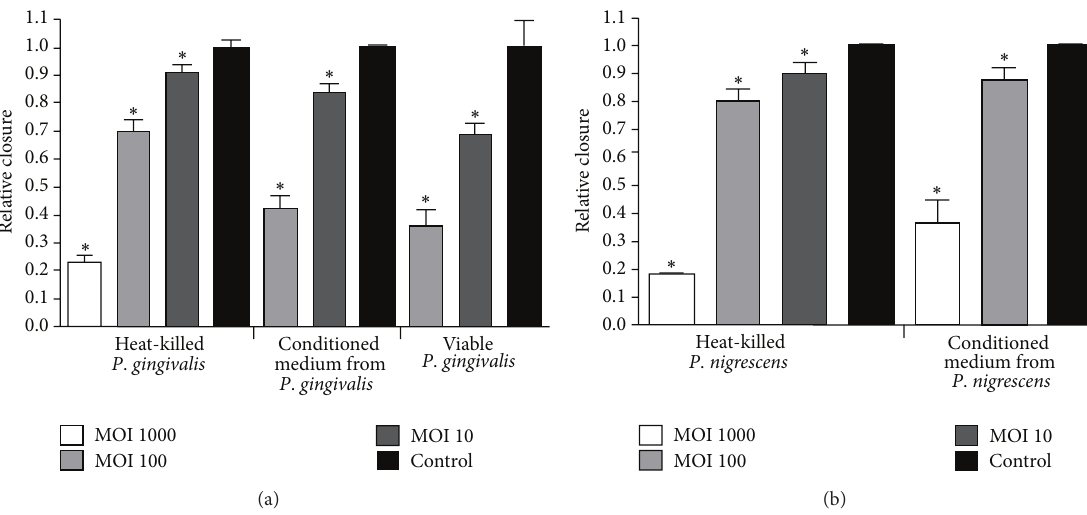
Figure 1: Relative closure (mean + SEM) of scratch in oral epithelial cells challenged with (a) different concentrations of heat inactivated P. gingivalis , conditioned medium from P. gingivalis , and viable P. gingivalis. Relative closure significantly different ( 𝑃 < 0.05 ) from control is marked with ∗ (b) different concentrations of heat inactivated P. nigrescens and conditioned medium from P. nigrescens . Relative closure significantly different ( 𝑃 < 0.05 ) from control is marked with ∗